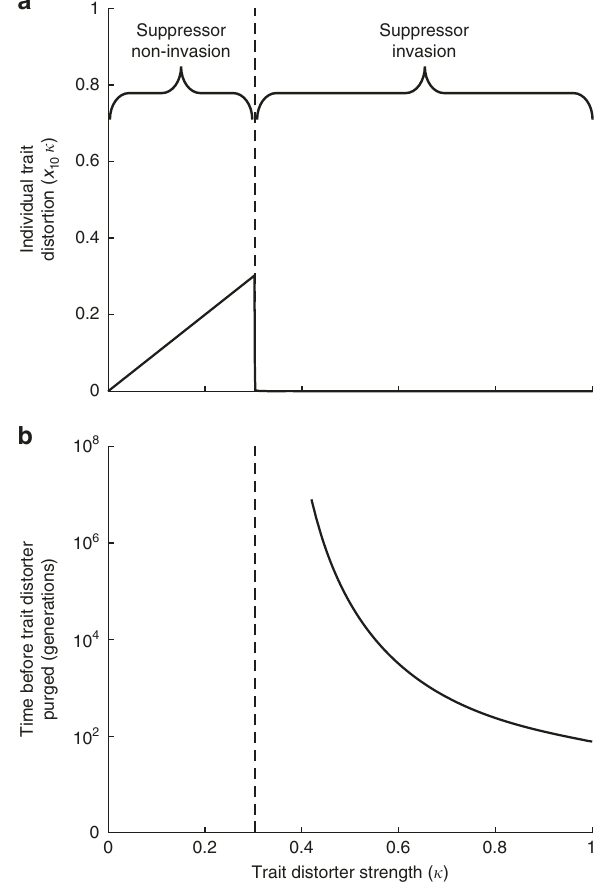
NATURE COMMUNICATIONS| (2019) 10:5163